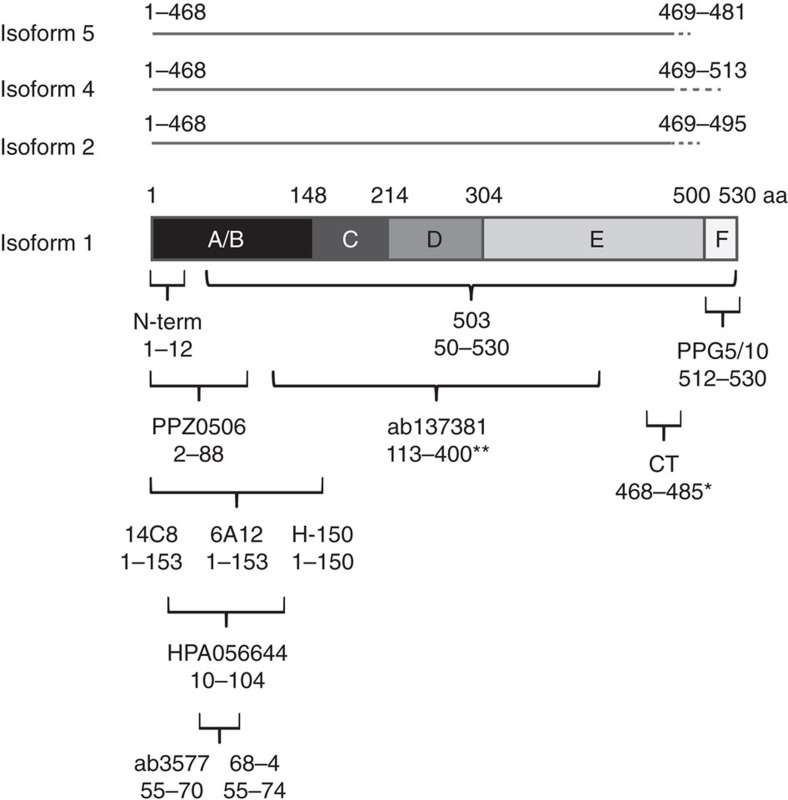
Schematic view of antibody epitopes and ERβ isoforms.Overview of ERβ isoforms and regions targeted by ERβ antibodies included in the study. PPZ0506, 14C8 and PPG5/10 are indicated in bold. The structural domains of the ERβ protein (A,B: amino-terminal and activating function AF-1 domain, C: DNA-binding domain, D: hinge region (with nuclear localization and dimerization binding), E: ligand-binding domain and AF-2, and F: carboxyterminal end).